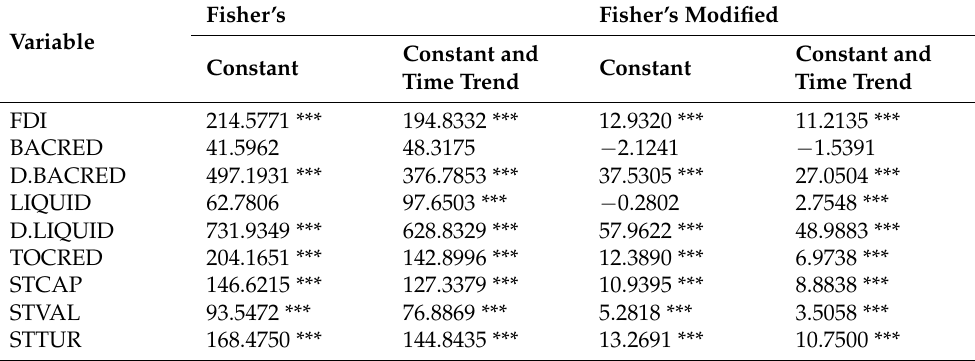
Table 3. The unit root tests for FDI and the financial proxies.